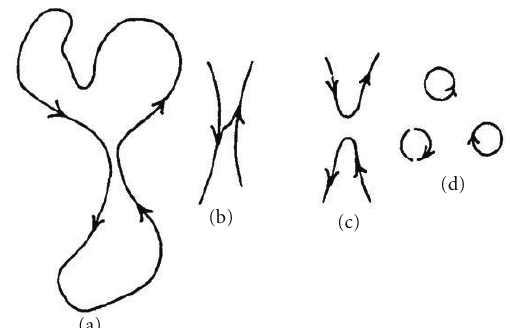
Figure 39: Sketch of vortex breakdown [39] (Tsubota et al, 2009). A vortex ring (a) can break up into smaller rigs if the transition between states (b) and (c) allowed when the separation of vortex lines becomes of atomic dimensions. The eventual small rings (d) may be identical to rotons.